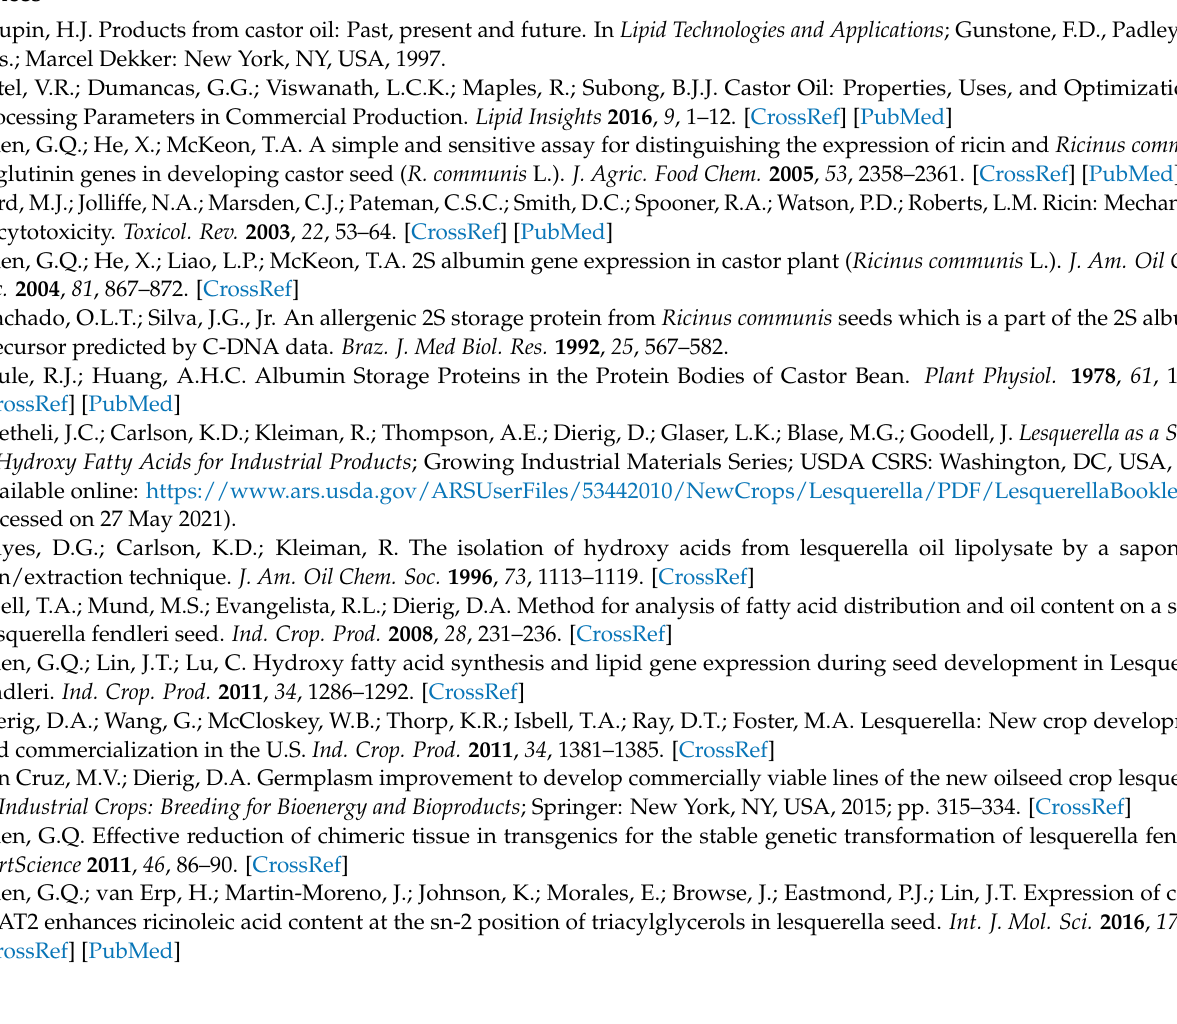
(T 1 seeds), Table S2: Fatty acid composition (mole%) in T 1 seeds expressing AtFAD3 RNAi + CsFAE1 RNAi , Table S3: Fatty acid composition (mole%) in T 1 seeds expressing CsFAD2 RNAi +